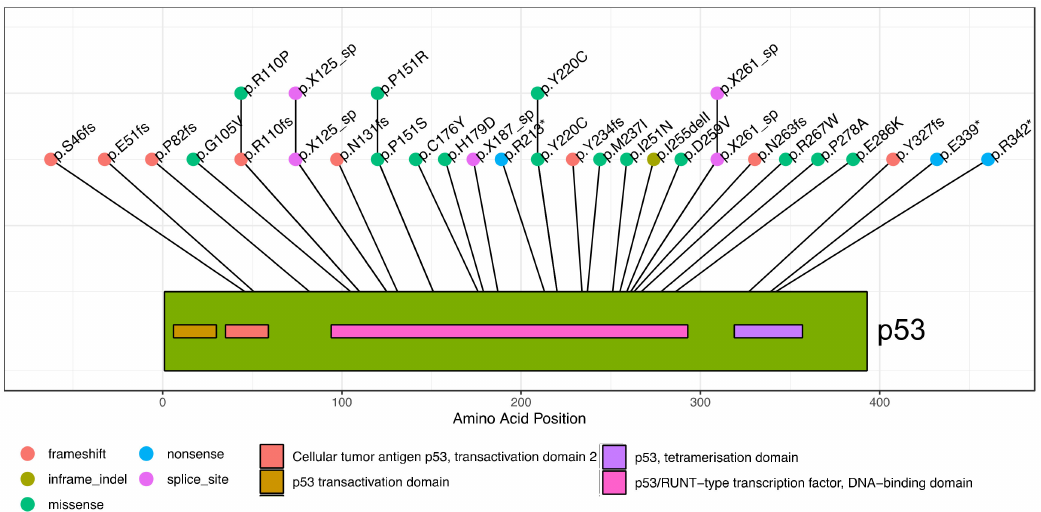
Figure 2. Lollipop plot showing location and sequence of TP53 mutations in breast cancer cohort. The individual mutations are indicated with their amino acid change given. Mutations preceded with “X” are splice site mutations, located within introns. The color of the lollipop indicates the mutation type. A schematic of the p53 protein is shown, with domains indicated in the color key below the